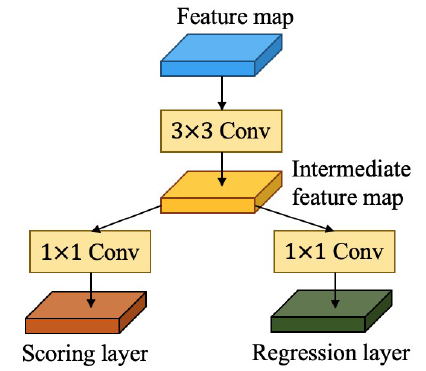
Figure 6. Region proposal